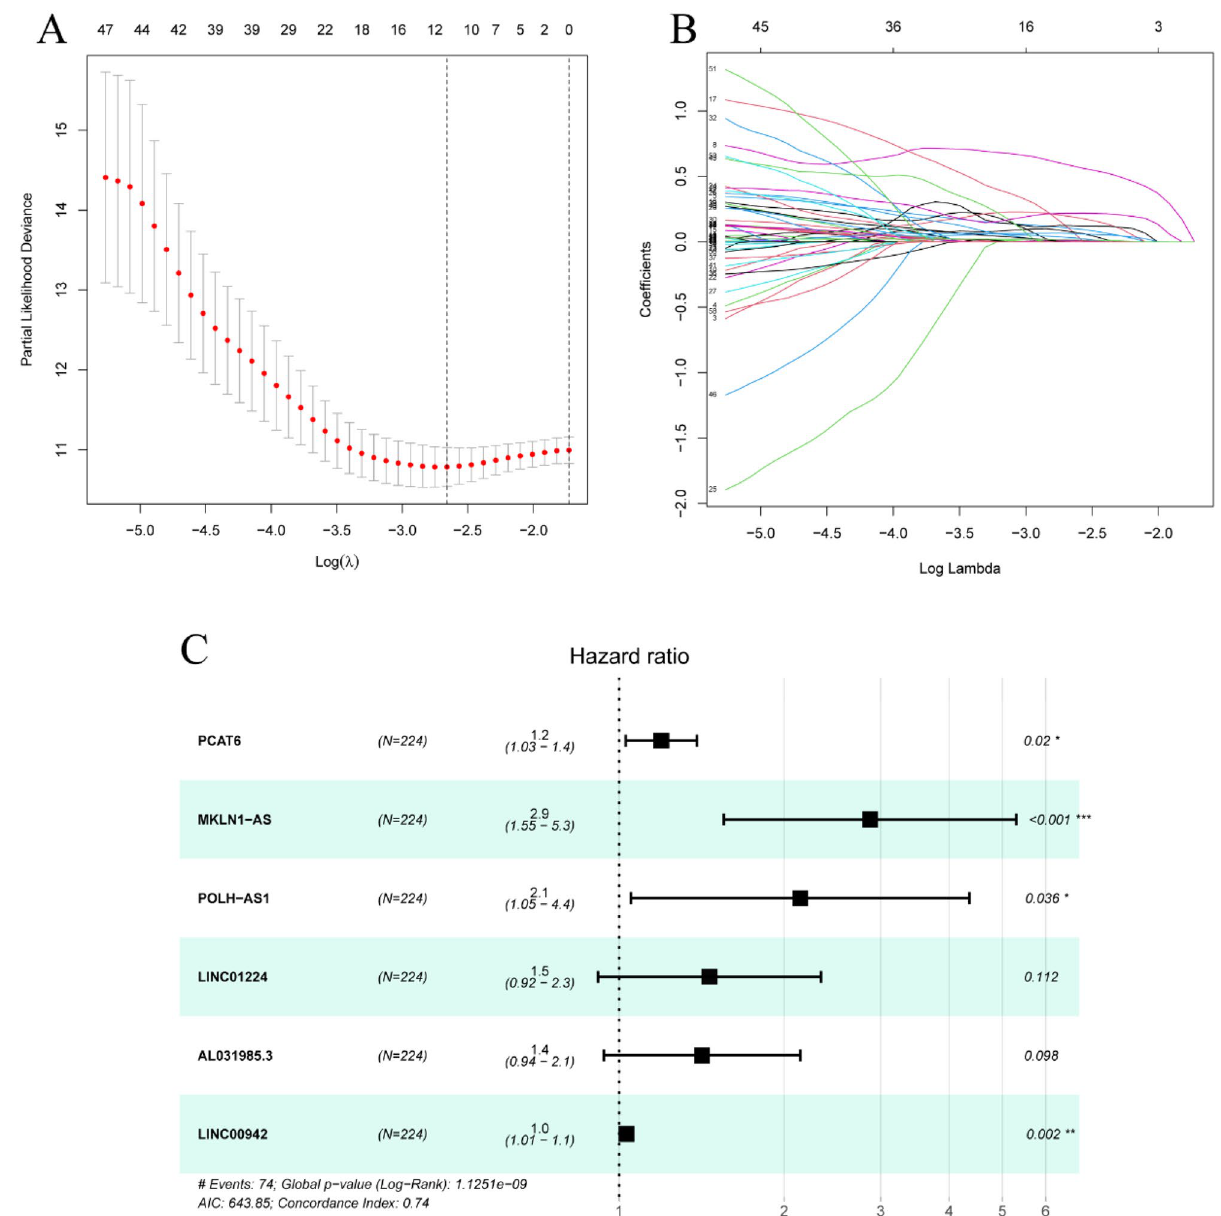
Figure 2. Six ferroptosis-related lncRNAs were selected to establish a prognostic signature. ( A ) Selection of the optimal turning parameters (log λ) through the tenfold cross-validation. ( B )The Lasso coefficient profile of 60 OS-related lncRNAs and imaginary perpendicular lines were drawn at the value chosen by tenfold cross- validation. ( C ) Multivariate Cox regression analysis showed 6 ferroptosis-related